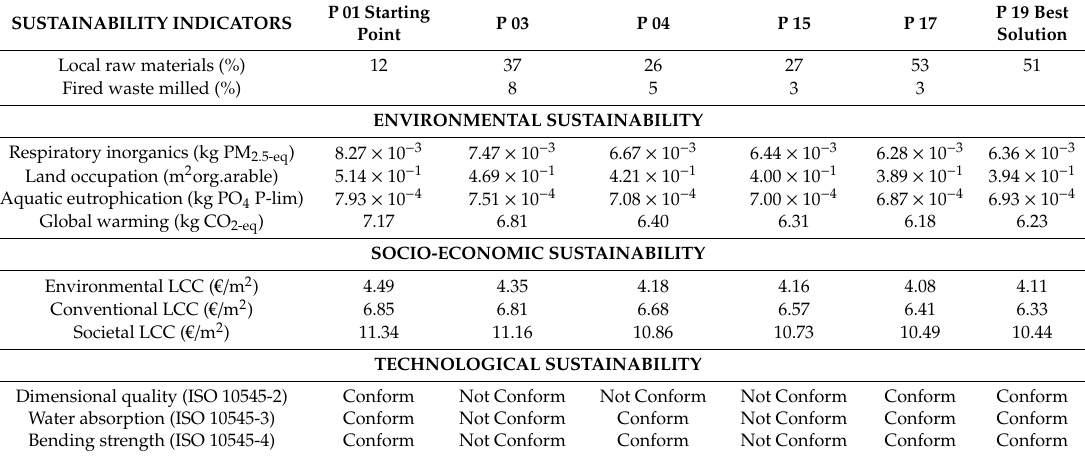
Table 5. Overview of environmental, socio-economic, and technological sustainability